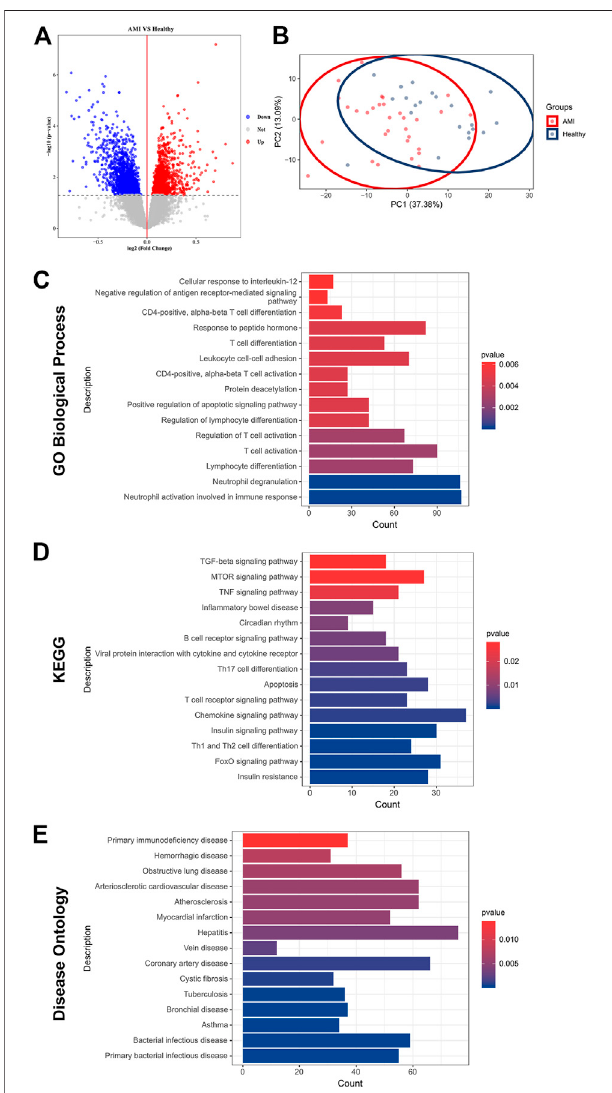
FIGURE 1 | Identi fi cation of DEGs and functional enrichment in AMI. (A) A volcano plot showing DEGs in AMI samples and healthy controls ( p < 0.05). Theup-regulatedgenesaremarkedinred,andthedown-regulatedgenesare marked in blue; (B) PCA of DEGs showing good differentiation power; (C) GO biological process enrichment analysis of DEGs; (D) KEGG enrichment analysis of DEGs; (E) DO enrichment analysis of DEGs.